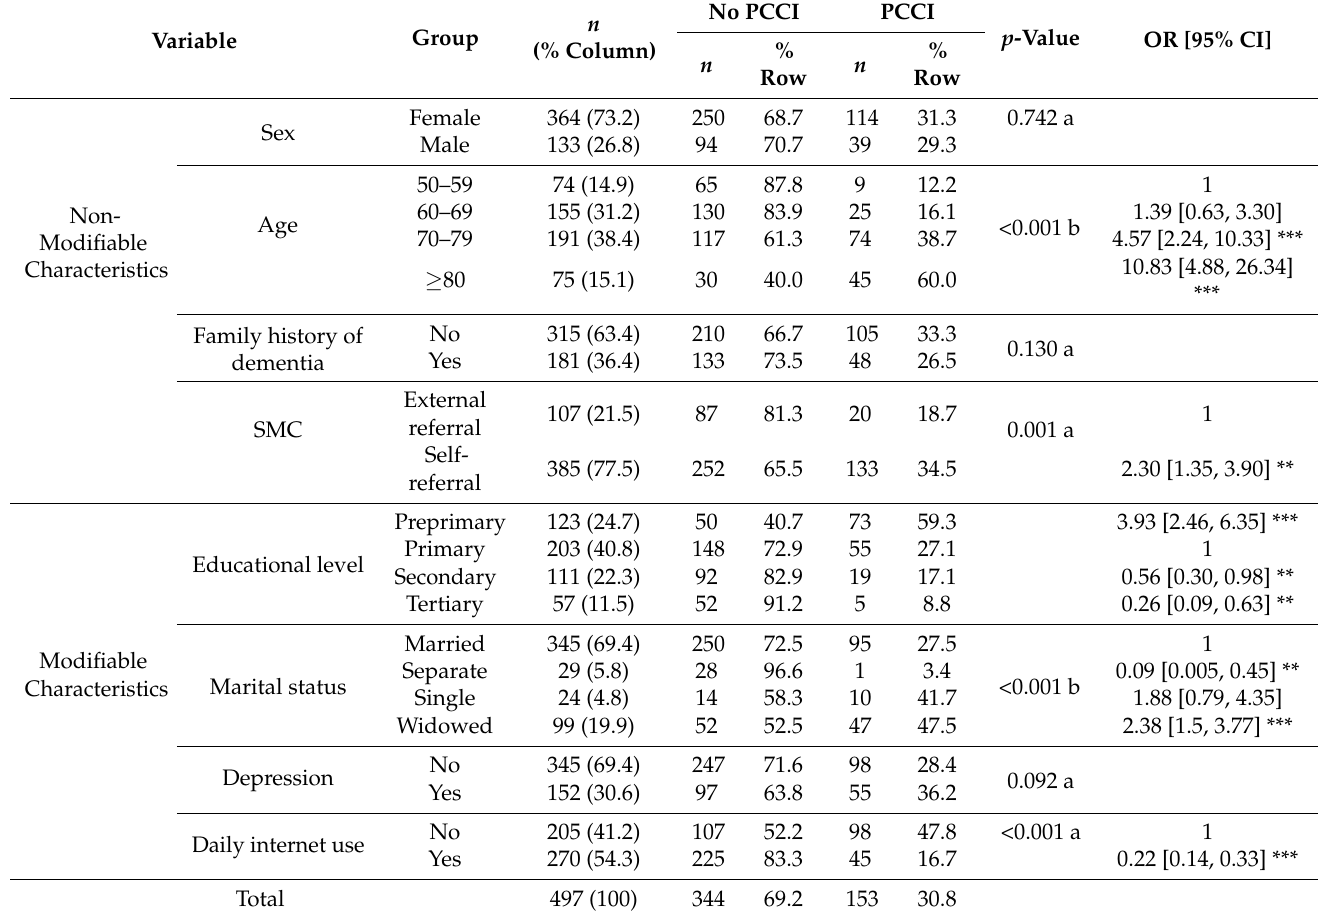
Table 5. Qualitative variables on patient’s